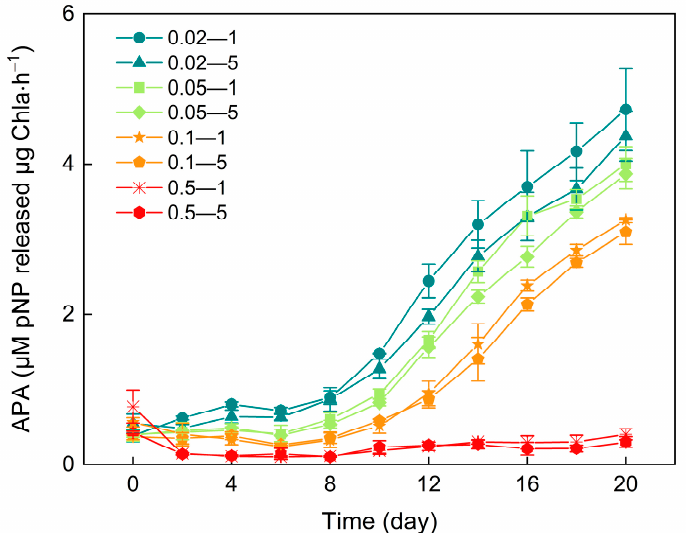
Figure 6. The changes in APA of C. ovalisporum in the different treatments.